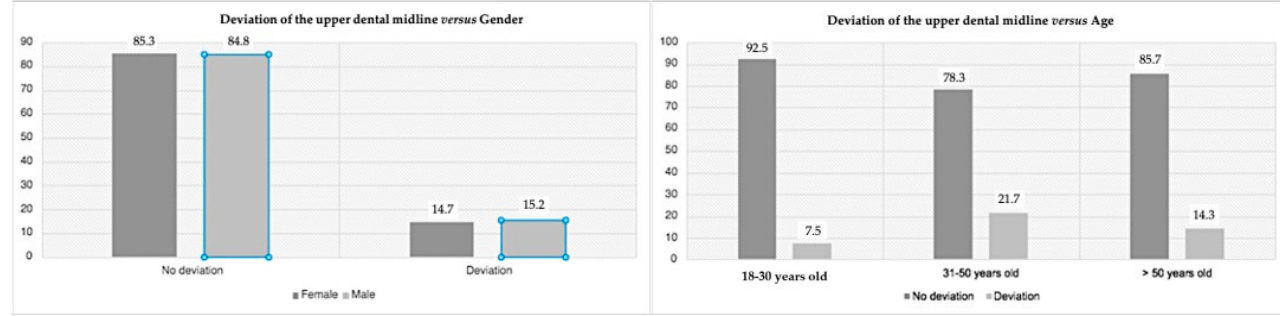
Figure 1. Prevalence of the deviation between upper dental midline and facial midline, according to gender ( left ) and age ( right ). On the other hand, the second variable studied (upper lip curvature) had significant results for gender and age (respectively, p = 0.049 and p = 0.032) (Figure 2). Of the 114 partic- ipants, 21 individuals (18.4%) had an upward curve of the upper lip, 50 individuals (43.9%) had a straight upper lip, and 43 individuals (37.7%) presented downward curvature of the upper lip. In females, the straight upper lip was the most prevalent (44.1%), while in males, the upper lip downwards was most prevalent (47.8%). A straight upper lip was the most prevalent in the younger class and the downward curve was the least prevalent. For elders, there was a greater prevalence of straight lips (women) and downward-facing curvature (men), with upward-facing curvature being the least prevalent.